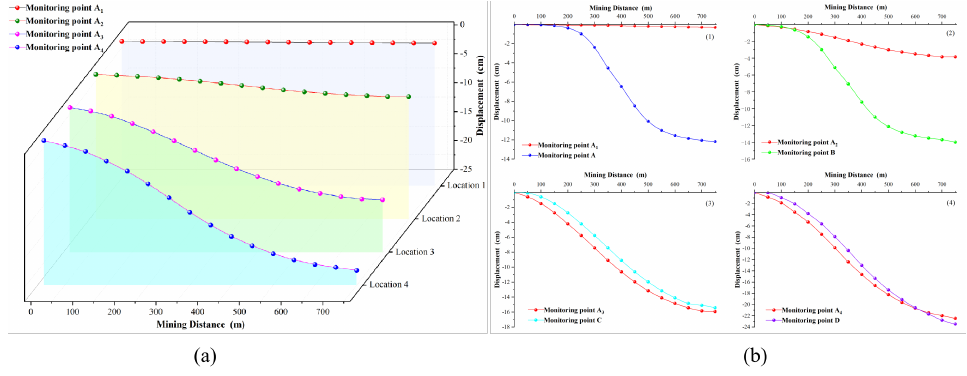
Figure 10. Comparison between the displacement of the corresponding position during mining and the change of the displacement of the top of the mountain: ( a ) variation of mountaintop displacement; ( b ) comparison of displacement changes.